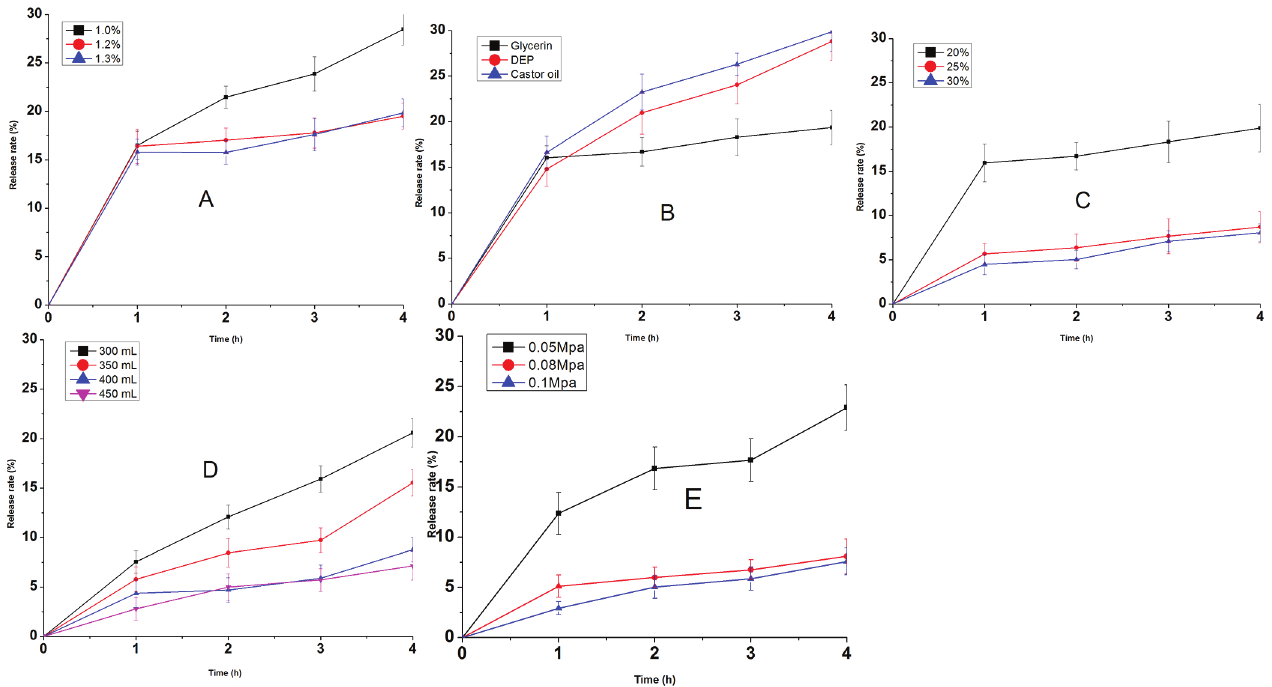
FIGURE 3 - The effect on dissolution rate in a simulated small-intestinal fluid (pH 6.8) of the chitosan concentration (A), the type of plasticizers (B), the concentration of plasticizers (C), the amount of coating fluid (D) atomizing press (E).